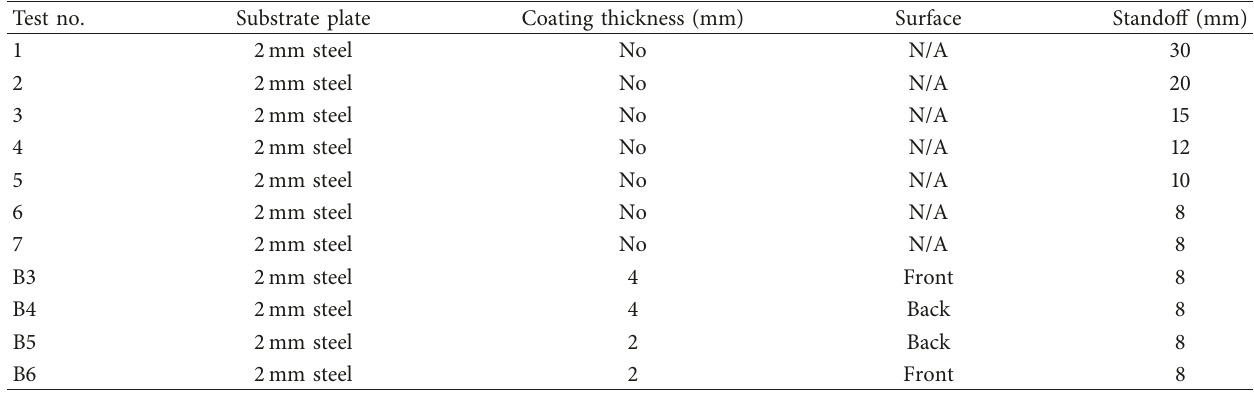
Table 4: Details of plates for blast tests.